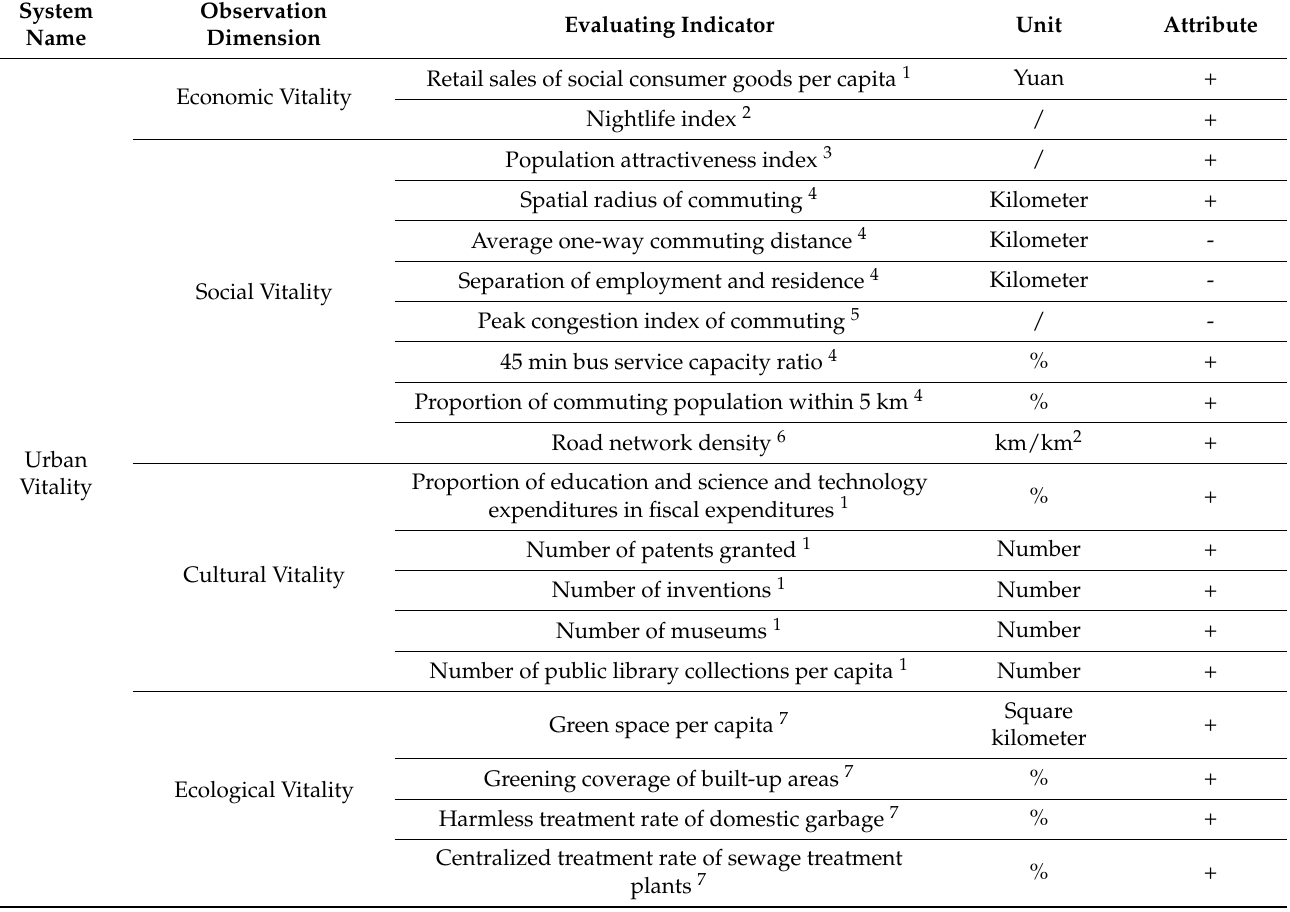
Table 2. Urban vitality evaluation